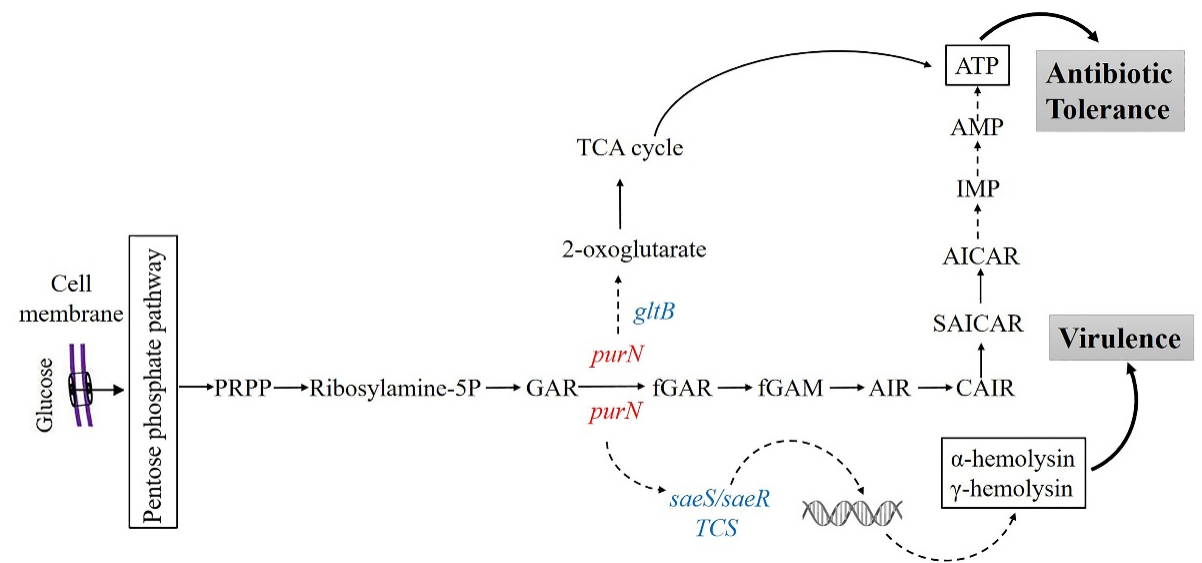
Figure 6. Pathways that indicate how purN is involved in persister formation and virulence in S. aureus.